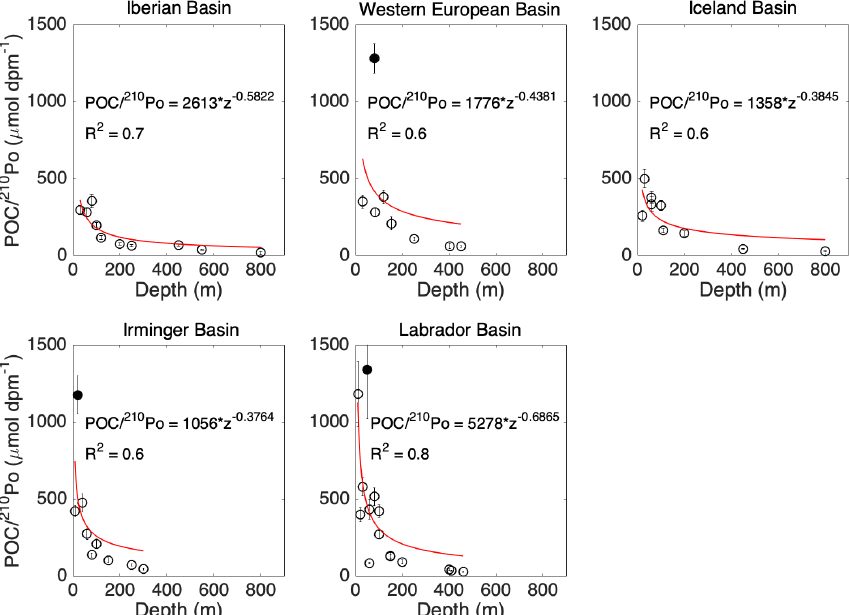
Figure 5. The ratios of POC concentration to 210 Po activity in the total particles vs. depth in each basin along the GA01 transect. Power law regression (red line) was fitted for POC / 210 Po against depth in each plot: the Iberian Basin (stations 1, 13), West European Basin (stations 21, 26), Iceland Basin (stations 32, 38), Irminger Basin (stations 44, 60), and Labrador Basin (stations 64, 69, 77). The data points denoted as filled by black circles were outliers (points at a distance greater than 1.5 standard deviations from the power law model) and excluded from the power law